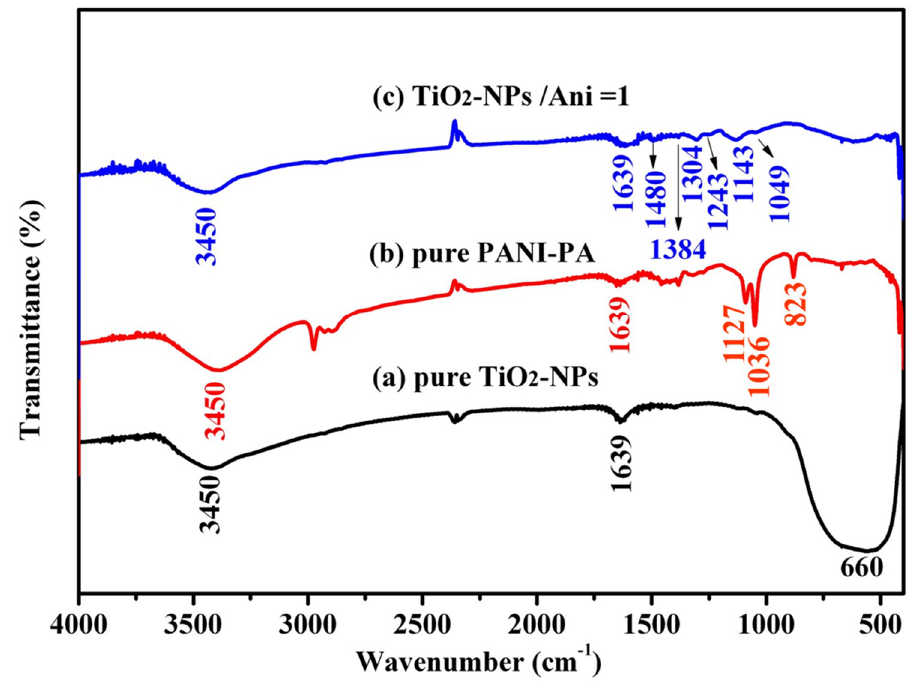
Figure 4. FTIR spectrum of ( a ) pure TiO 2 NPs; ( b ) the pure PANI and ( c ) TiO 2 @PANI products at m (TiO 2 )/m (Ani) = 2.